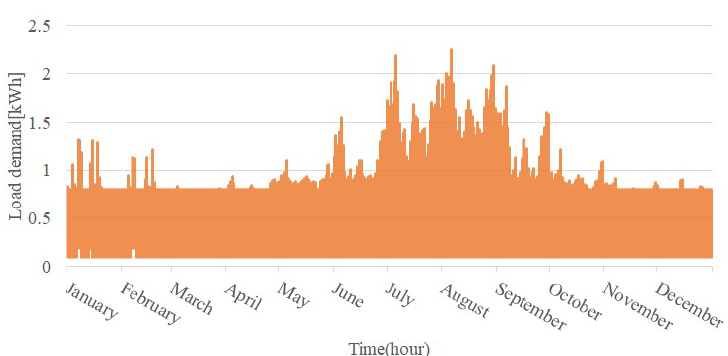
Figure 18. Estimated annual electricity demand in the selected residential building in Kasuga city.